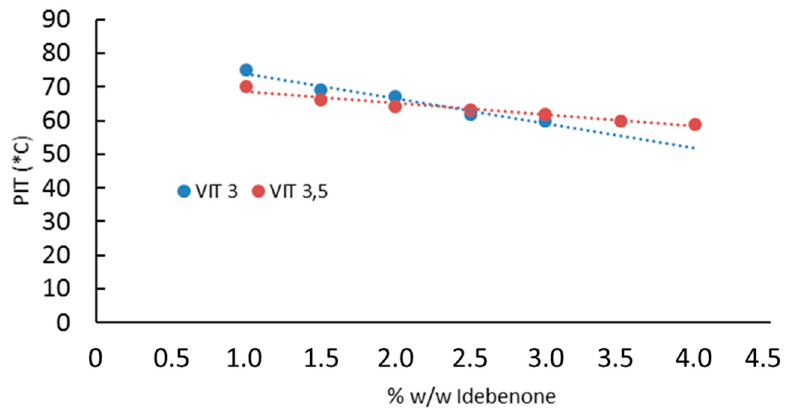
Figure 4. Relationship between PIT values and percentages of idebenone of NLC containing tocopheryl acetate 3.0% w / w (VIT 3) or tocopheryl acetate 3.5% w / w (VIT 3,5).